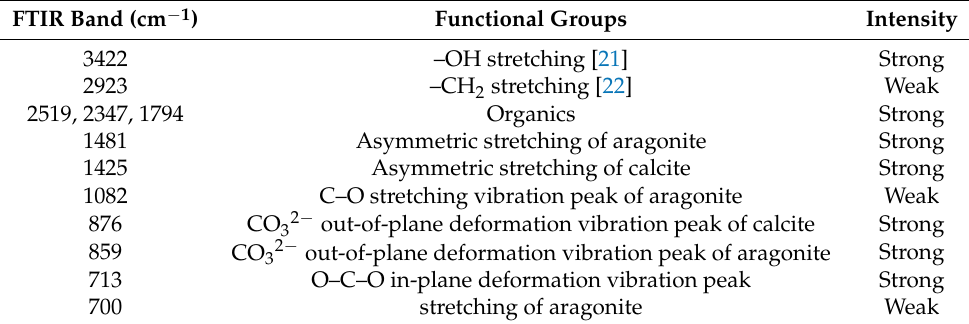
The XRD patterns of the shell bio-fillers are shown in Figure 2. The XRD pattern of the CES bio-filler matches with the calcite (CaCO 3 , PDF#86-2334) pattern and the main phases of the CHS powder are identified as calcite (CaCO 3 , PDF#86-0174) and aragonite phases (CaCO 3 , PDF#75-2230). The CMS belongs to a typical aragonite structure (CaCO 3 , PDF#71-2396) without any characteristic of the calcite phase. These results are confirmed by the results of FTIR spectra in Figure 2, which is also consistent with the previous reports [7,8,19,23].